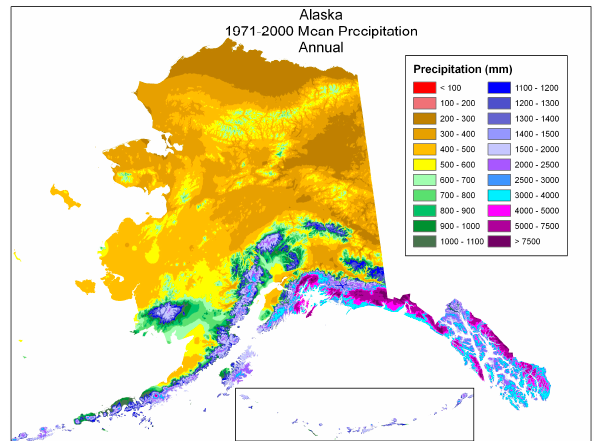
Figure 1. Precipitation map for the 1971–2000 normal time period using PRISM model data (Oregon State University).